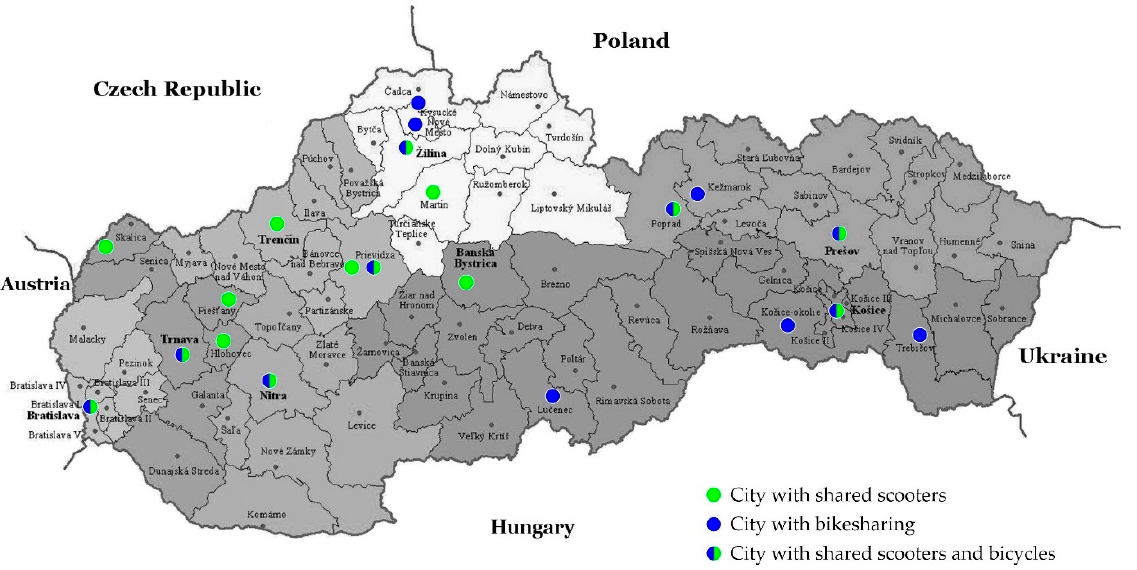
Figure 1. List of cities with shared mobility in Slovakia.